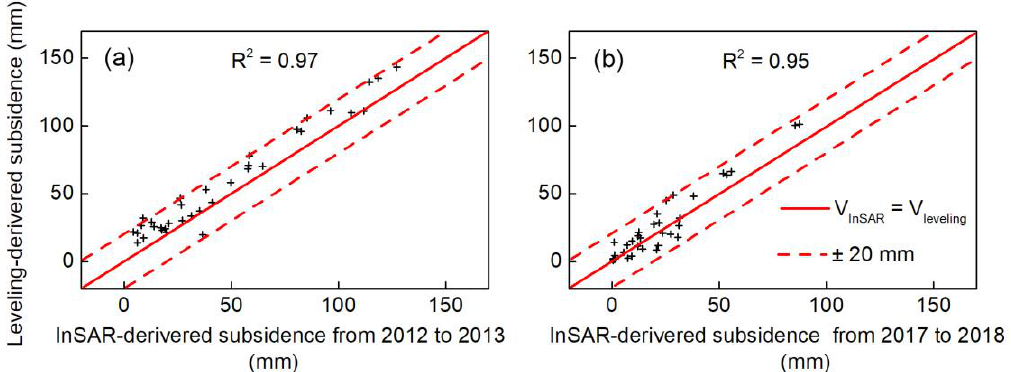
Figure 10. Comparison between InSAR-derived land subsidence and leveling-derived observations at 70 leveling benchmarks, whose locations are shown in Figure 1a with levelings-II. There are 35 leveling benchmarks from 2012 to 2013 in ( a ) and 2017 to 2018 in ( b ), respectively.